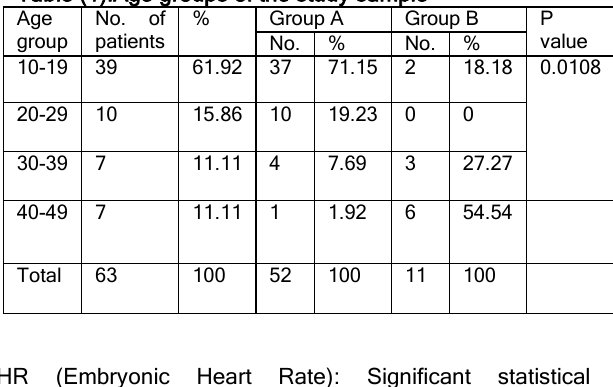
Table (1):Age groups of the study sample